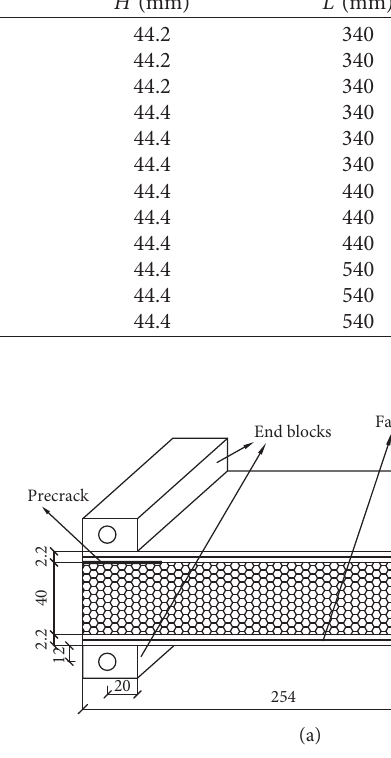
Figure 3: (a) Test setup of DCB tests (unit: mm); (b) DCB